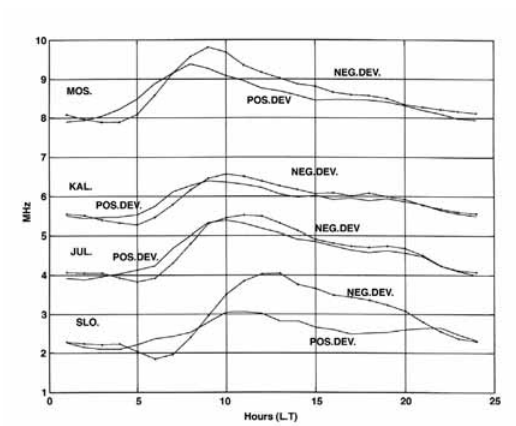
Fig. 6. Positive (solid line) and negative (dotted line) deviations for Slough, Juliusruh, Kaliningrad, Moscow (in the 50 ° N-57 ° N latitude band). Plots are shifted each by 2